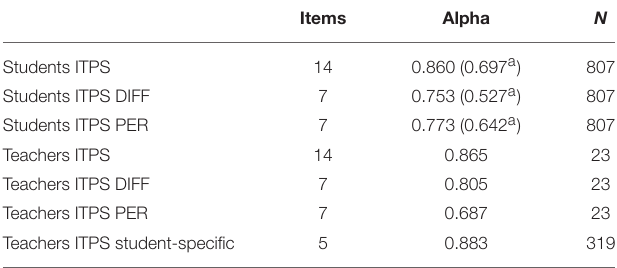
TABLE 1 | Reliability statistics (Cronbach’s alpha).